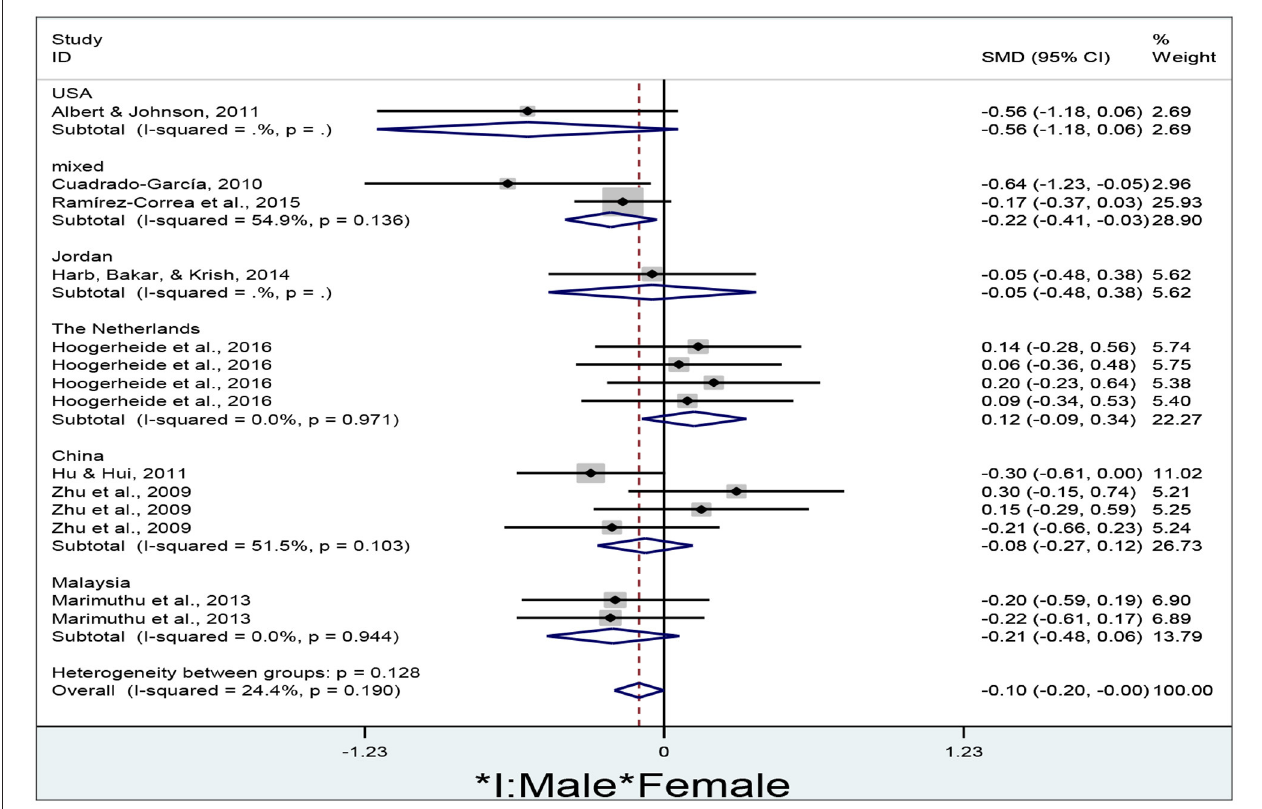
FIGURE 9 | Gender differences in e-learners’ performance in different